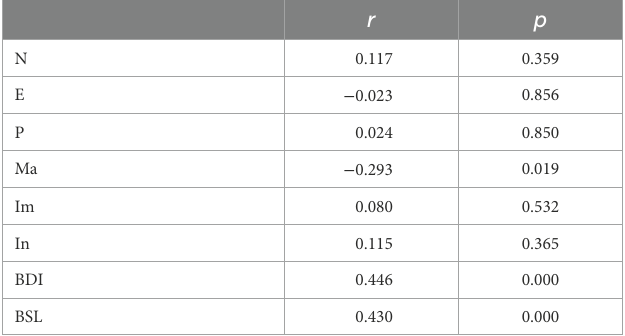
TABLE 3 The relationship between the frequency of NSSI last month and psychological measurements in MDD with NSSI group.